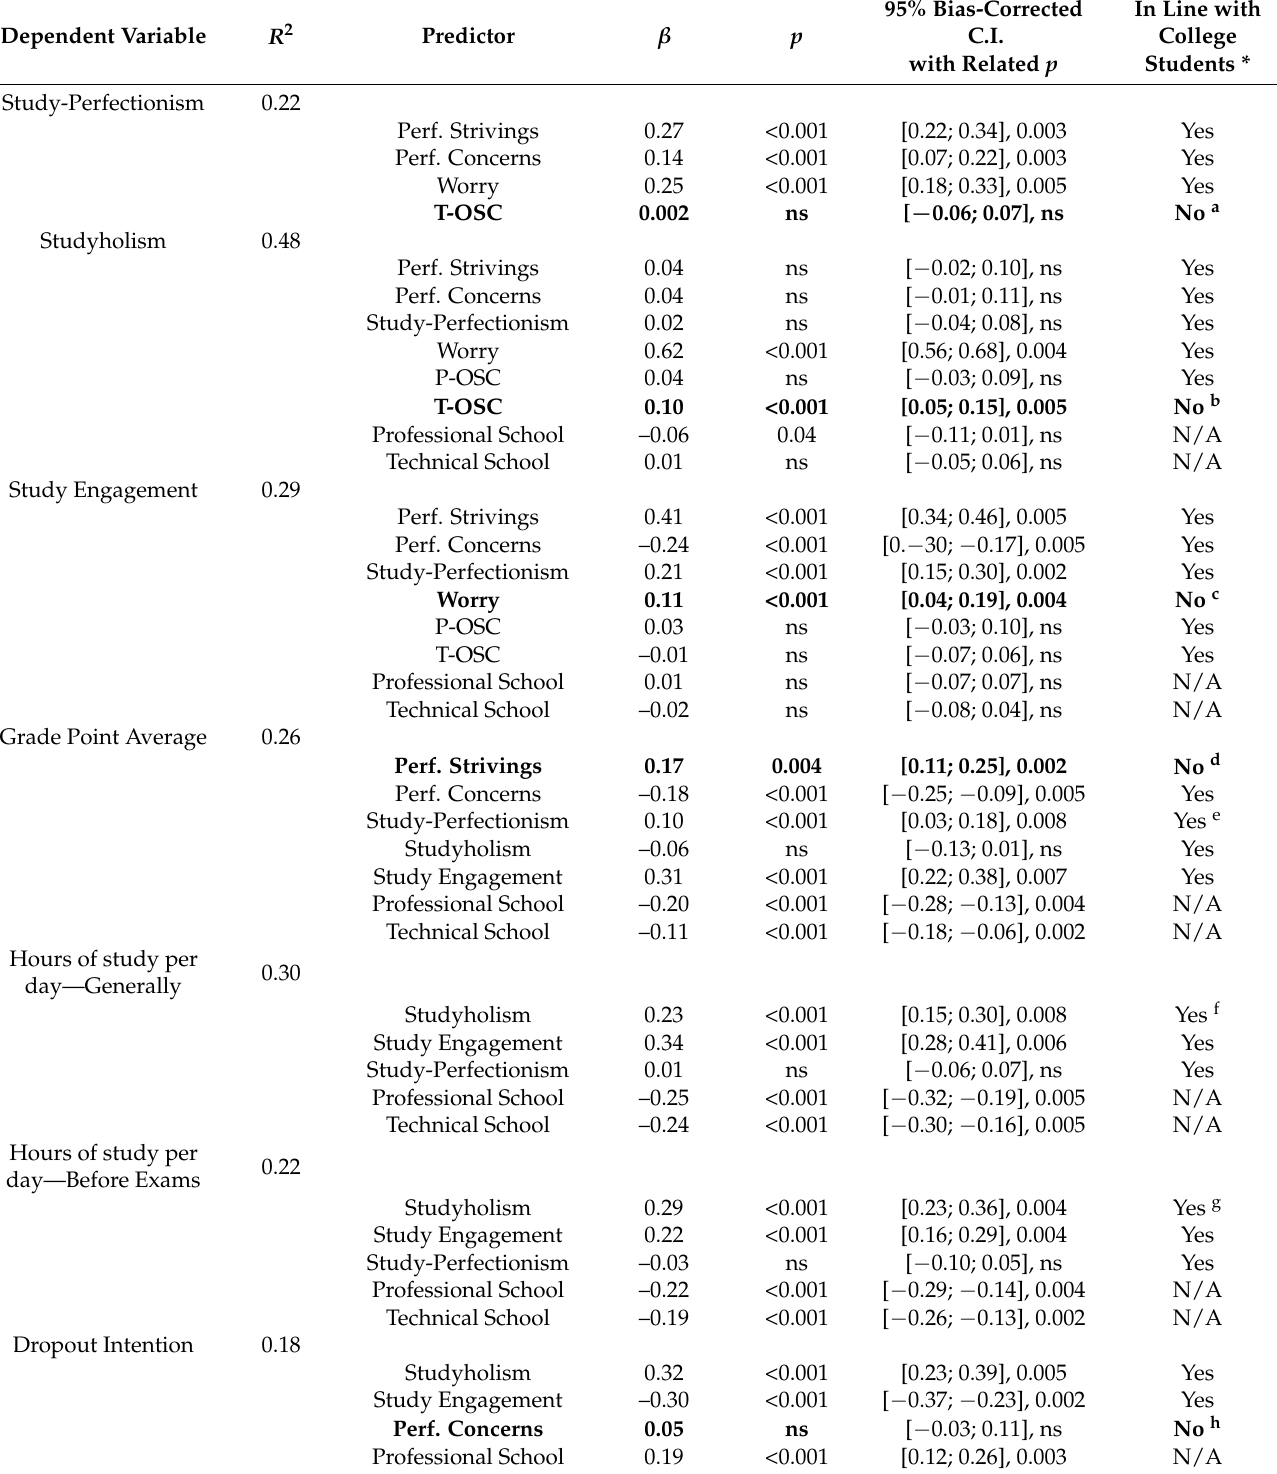
Table 3. Standardized path weights, 95% bias-corrected confidence interval, and R 2 for each dependent variable of the path analysis model ( n =